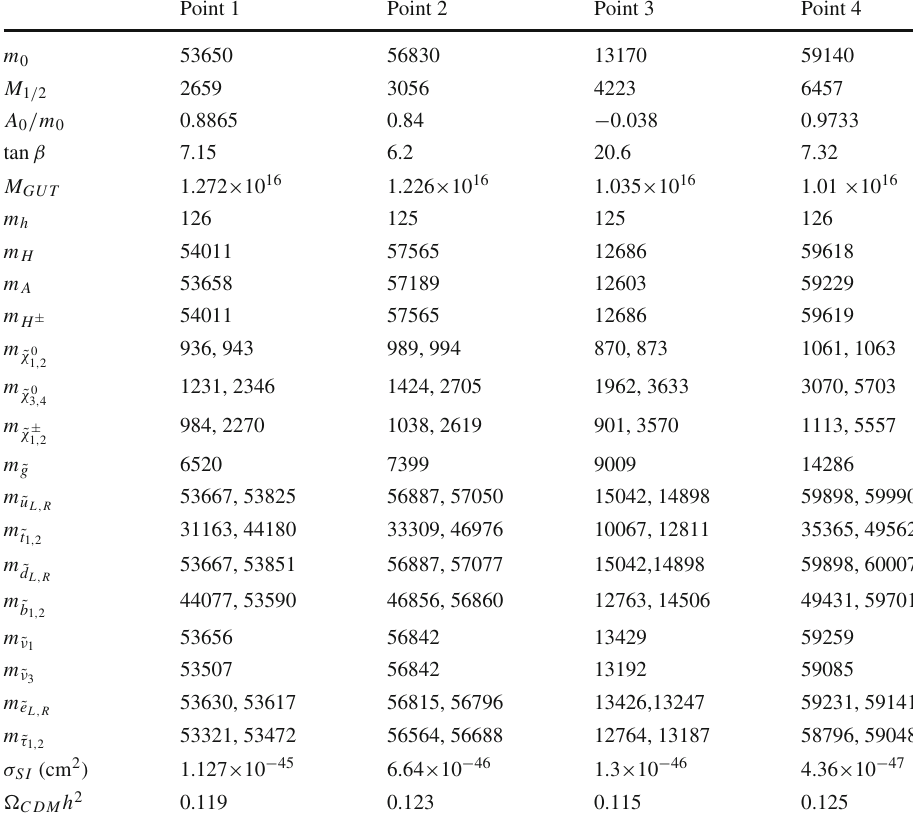
Table 1 Four benchmark points for the red and blue points, which are consistent with the dark matter relic density bounds. Sparticle and Higgs masses are in GeV